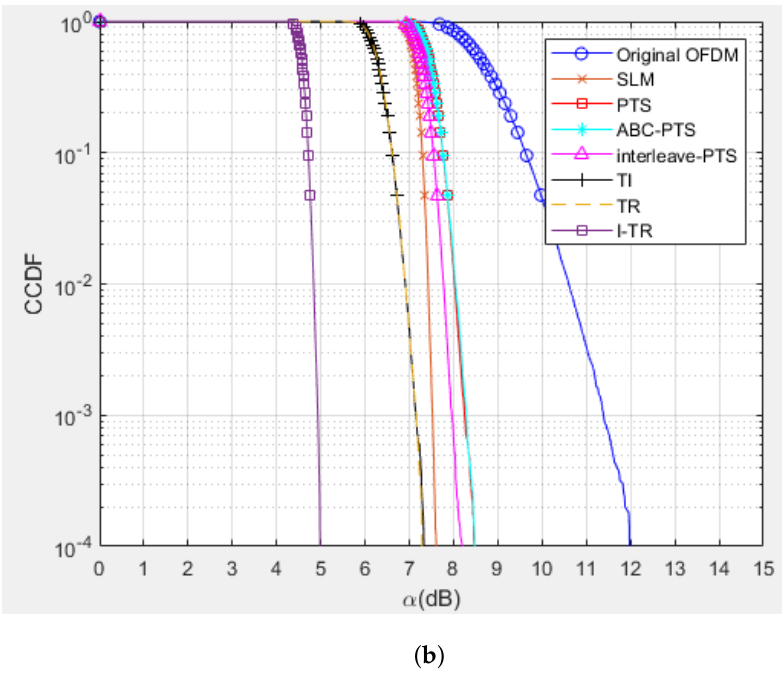
Figure 10. The PAPR performance of the different schemes for 64–QAM ( a ) N = 512 and ( b ) N =